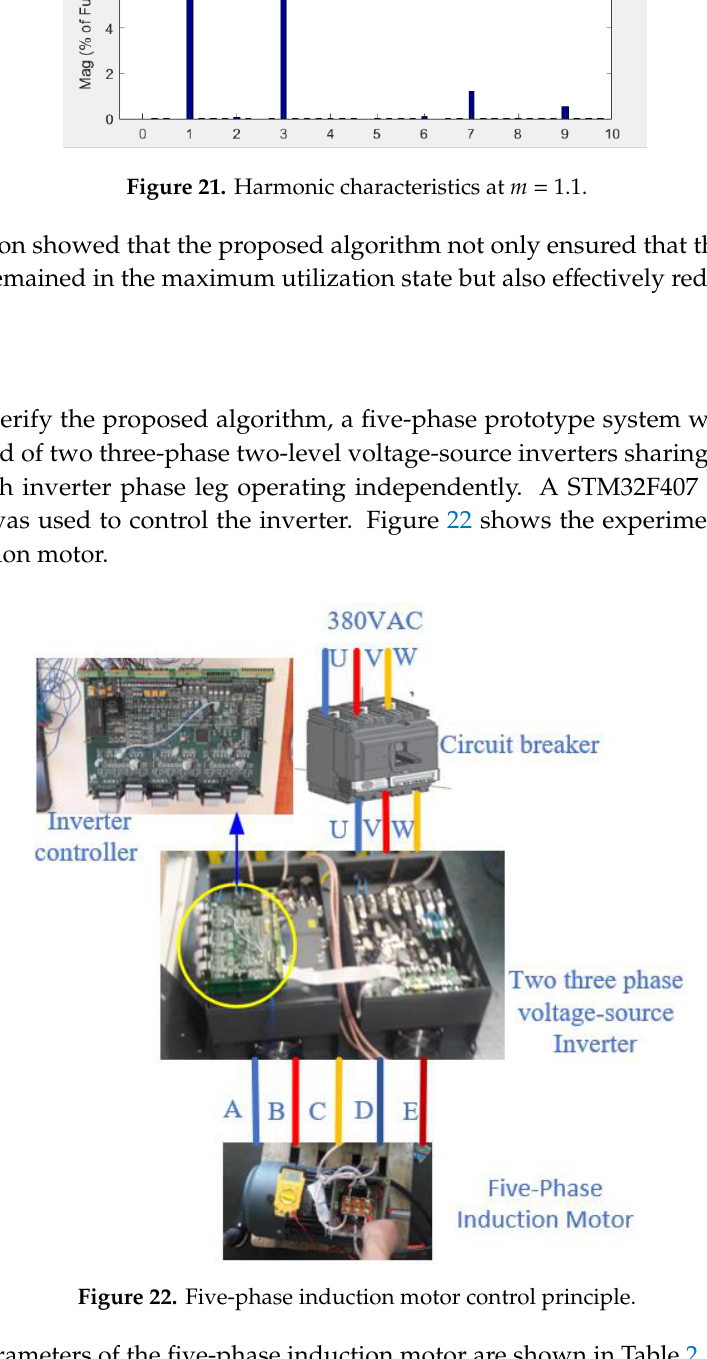
Table 2. Main parameters of the five-phase induction motor.